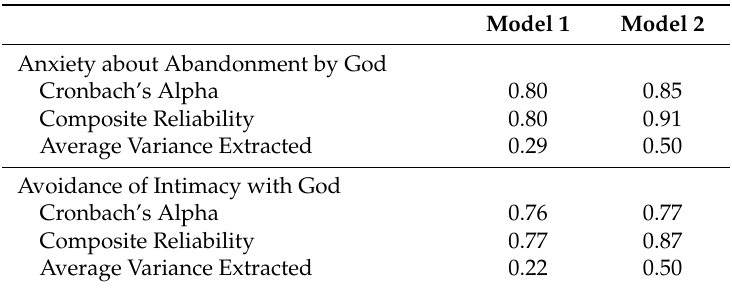
Table 2. Reliability and Convergent Validity in Models 1 and 2.